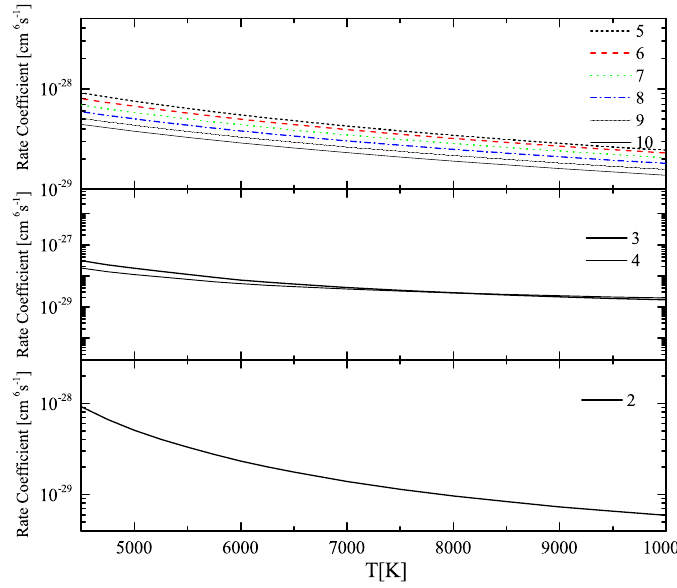
Figure 3. Same as in Figure 2 but for inverse process (i.e., recombination